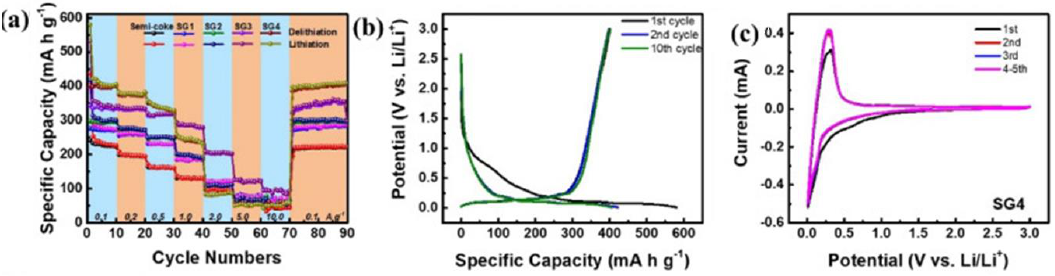
Figure 4. ( a ) Galvanostatic lithiation/delithiation curves, ( b ) Lithiation/delithiation voltage profiles and ( c ) cyclic voltammetry curves of semi-coke derived graphene anode measured at a scanning rate of 0.5 mV s −1 . Reproduced, adapted and reprinted with permission from Reference [77] .